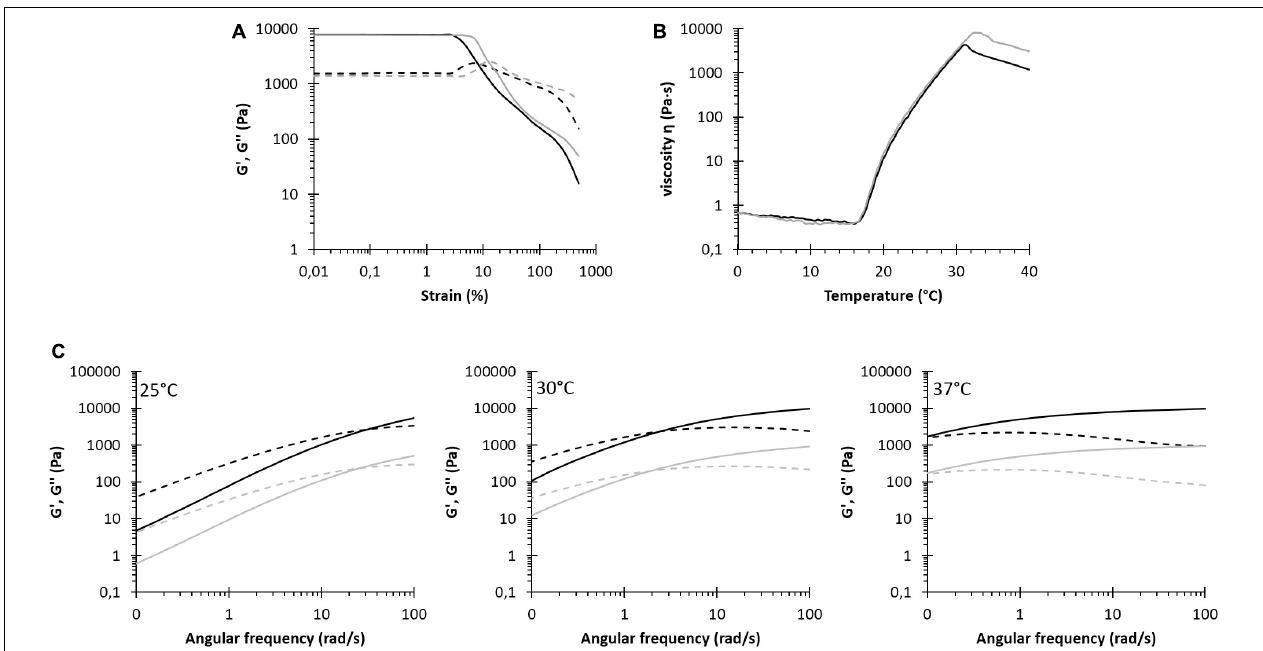
FIGURE 5 | Rheological characterization of NHP407_MSN-CS-SIP (black) and SHP407_MSN-CS-SIP (gray) hydrogels. (A) Storage (G (cid:48) , continuous line) and loss (G (cid:48)(cid:48) , dashed line) moduli trends as a function of applied strain at 37 ◦ C. (B) Trend of viscosity ( η ) as a function of temperature within 0–40 ◦ C range. (C) G (cid:48) and G (cid:48)(cid:48) trends (continuous and dashed lines, respectively) as a function of angular frequency at 25, 30, and 37 ◦ C. G (cid:48) and G (cid:48)(cid:48) values of SHP407_MSN-CS-SIP hydrogels were divided by a factor of